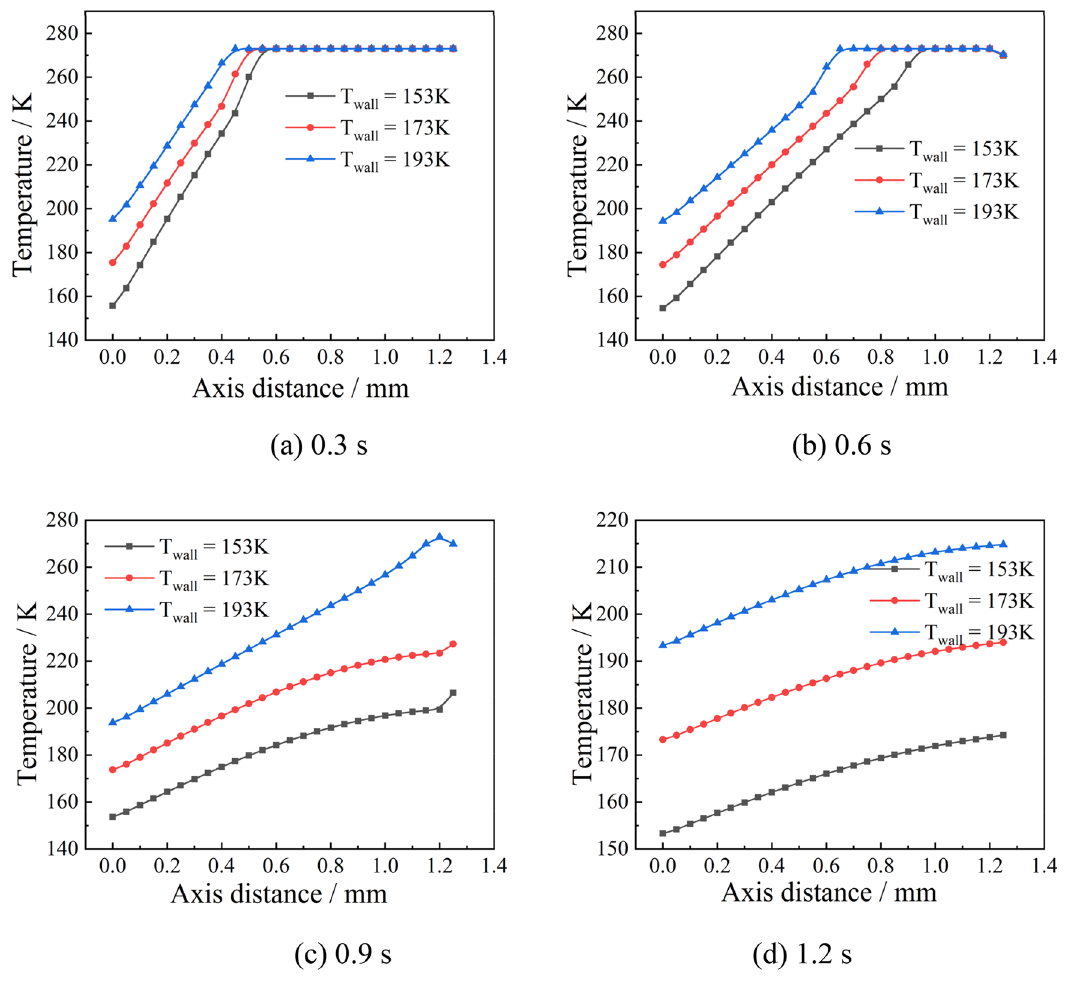
Figure 20. Temperature variation at the axis of the